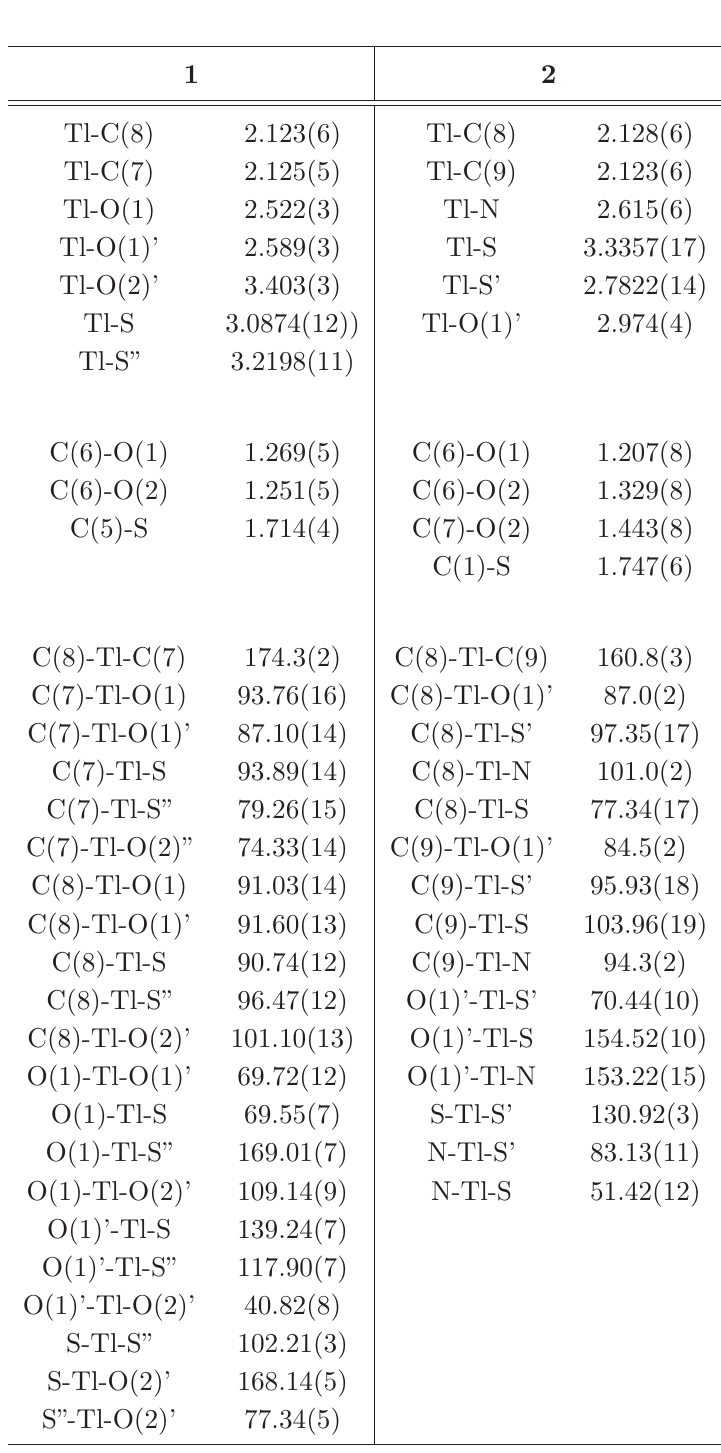
Table 5 Selected bond lengths (˚A) and angles (deg.) for compounds 1 and 2